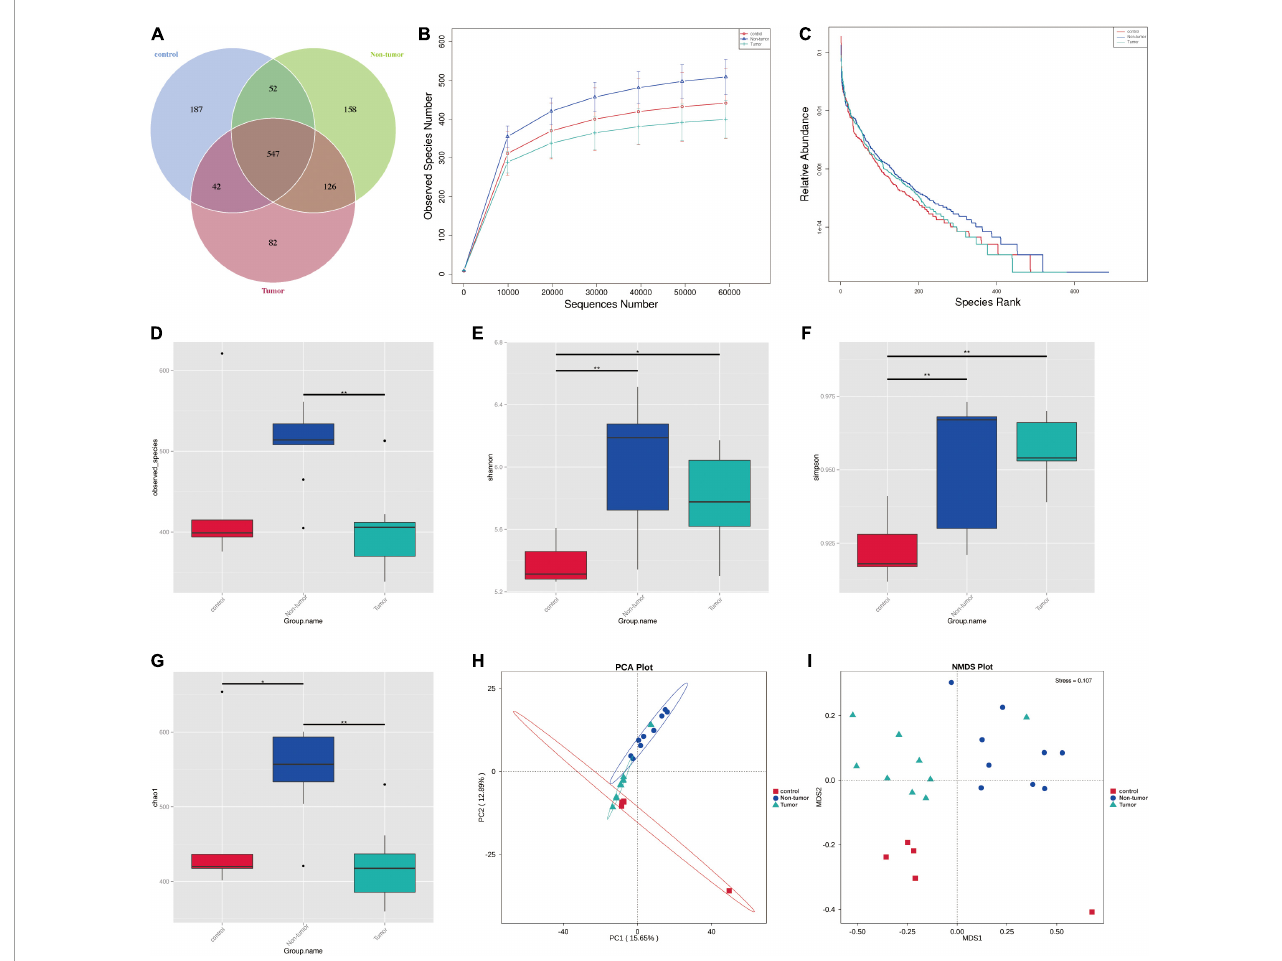
FIGURE2 The diversity of the microbial communities in three groups. (A) Venn diagram shows the compositions of OTUs. (B) Rarefaction curve. (C) Rank abundance curve. (D–G) Alpha diversity index analysis (ACE, Shannon, Simpson, and Chao1). (H) Principal component analysis; (I) NMDS analysis. * p < 0.05, ** p <